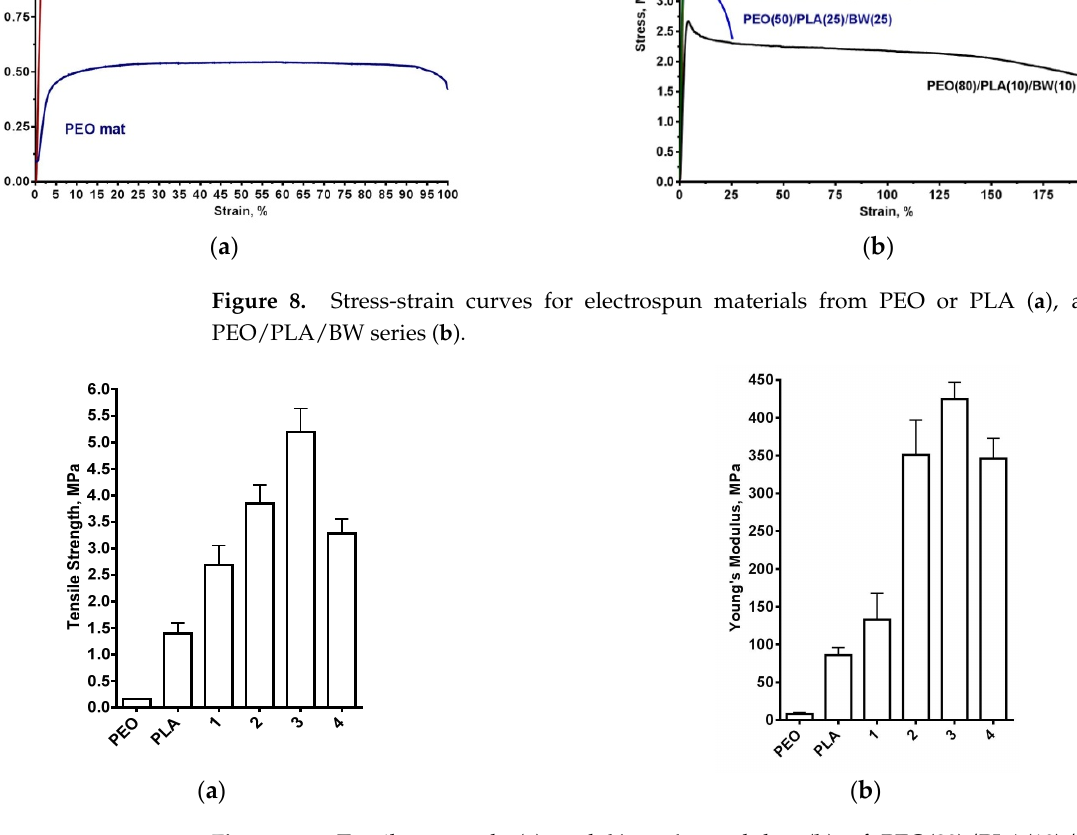
Figure 9. Tensile strength ( a ) and Young’s modulus ( b ) of PEO(80)/PLA(10)/BW(10) (1); PEO(70)/PLA(15)/BW(15) (2); PEO(60)/PLA(20)/BW(20) (3) and PEO(50)/PLA(25)/BW(25) (4) mats. For comparison, the values of these parameters are given for PEO and PLA mats, as well.